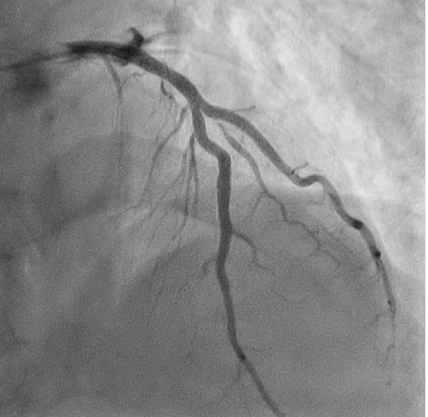
Figure 4: Anterior-posterior cranial view showed the widely dilated proximal portion of the second diagonal branch after percutaneous coronary